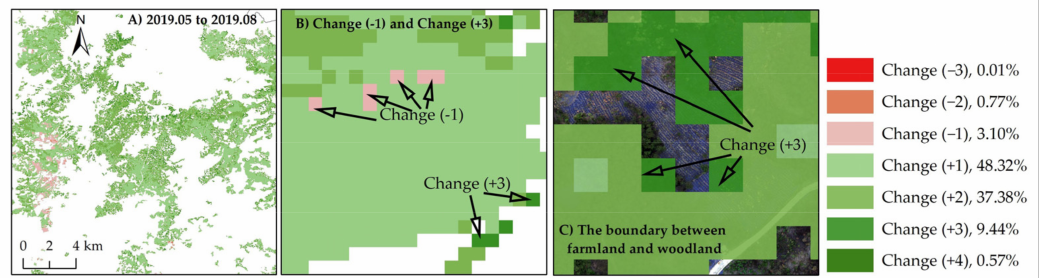
Figure 4. NDVI changes from May to August 2019. ( A ) ∆ NDVI for May versus August 2019. ( B ) Loca- tion of Change (+3) and Change ( − 1). ( C ) The interface between agricultural land and